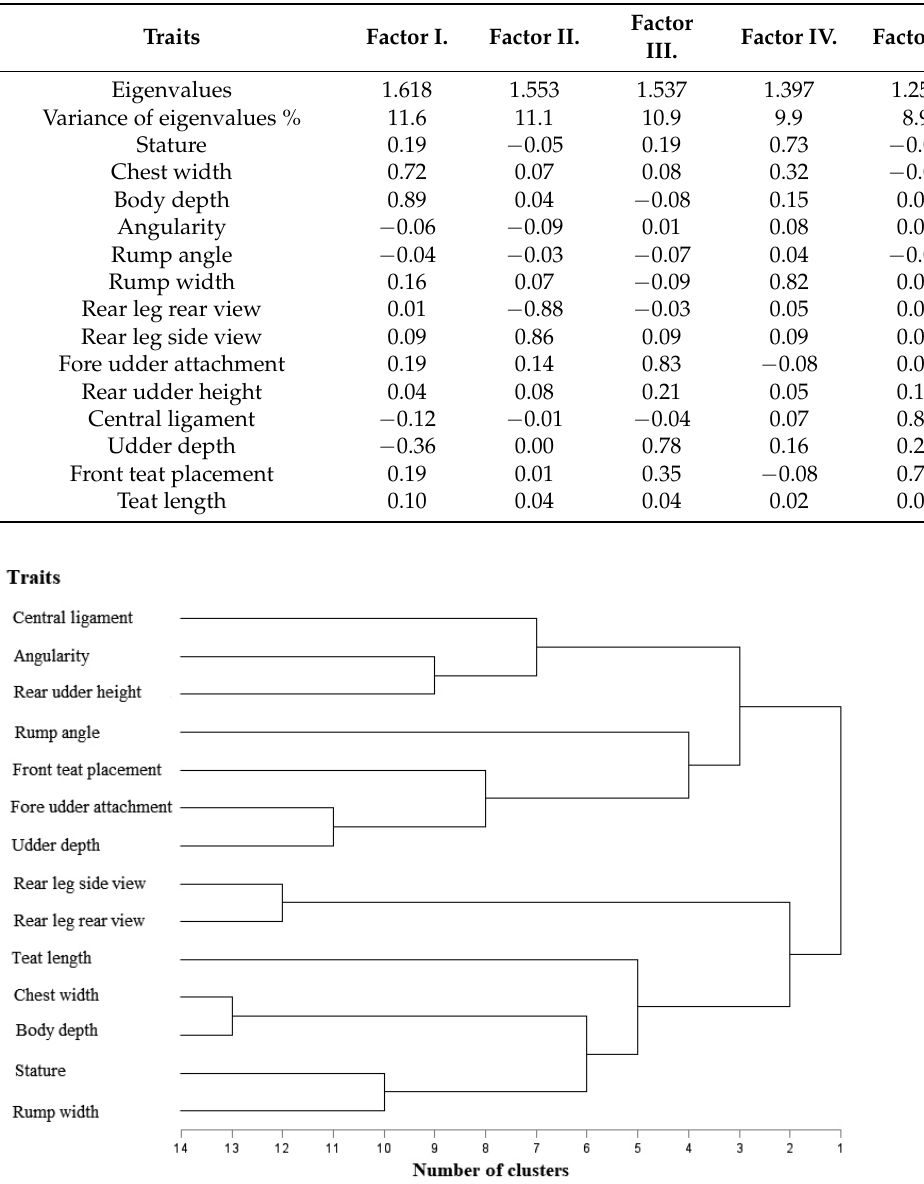
Figure 1. Dendrogram of linear type traits.